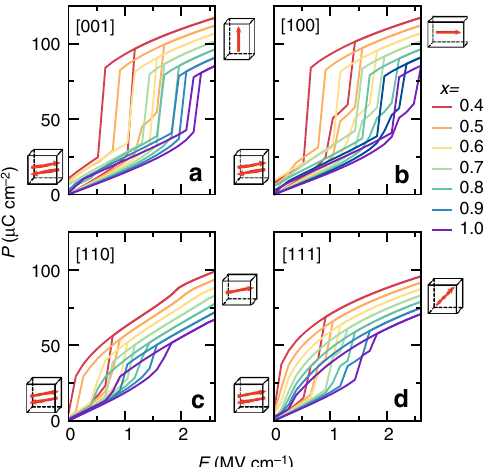
Figure 3 | Calculated P – E hysteresis curves of Bi 1 (cid:2) x Nd x FeO 3 solid solutions. Nd composition ranges between 0.4 and 1.0, and four different electric field orientations are considered. ( a ) [001]. ( b ) [100]. ( c ) [110]. ( d ) [111]. The displayed polarization is the projected component of the total polarization along the direction of the applied E -field. The arrows inside the boxes (on the sides of each panel) schematize the direction of the long-range-ordered electric dipoles in the initial and final states. The different colours used for the solid lines denote compositions ranging from x ¼ 0.4 to 1.0, as shown by the legend on the